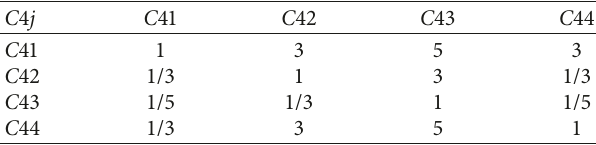
Table 8: Judgment matrix of C 4 j .